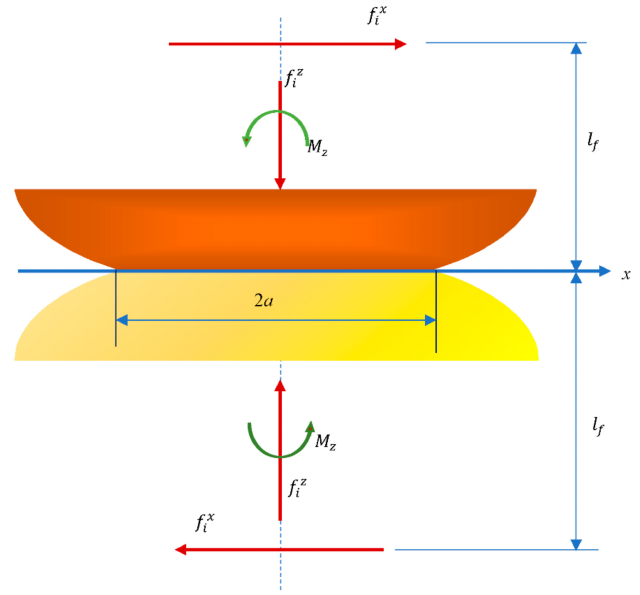
Figure 1. The deformation between two contacting surfaces (along the x